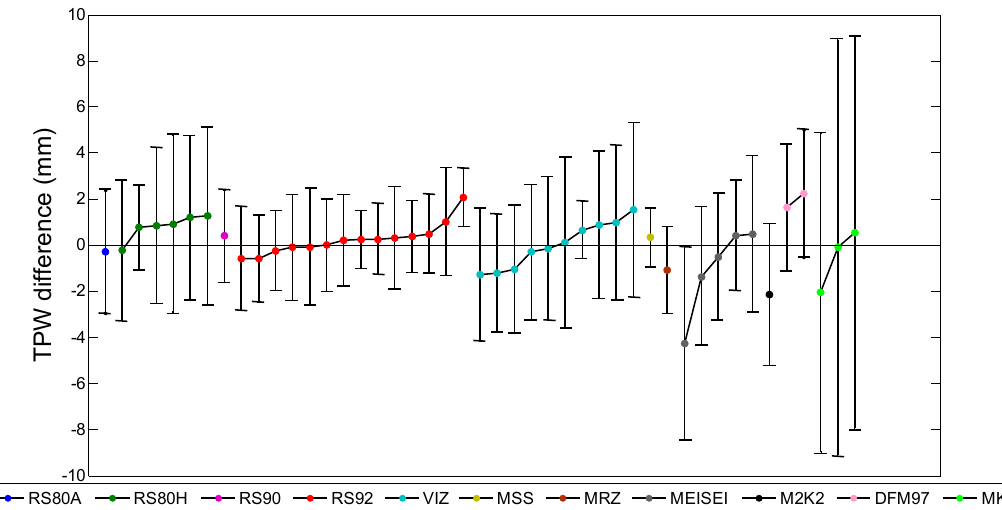
Figure 6. Mean values and standard deviations of the TPW di ff erences (Satellite-RS) for 11 radiosonde types.